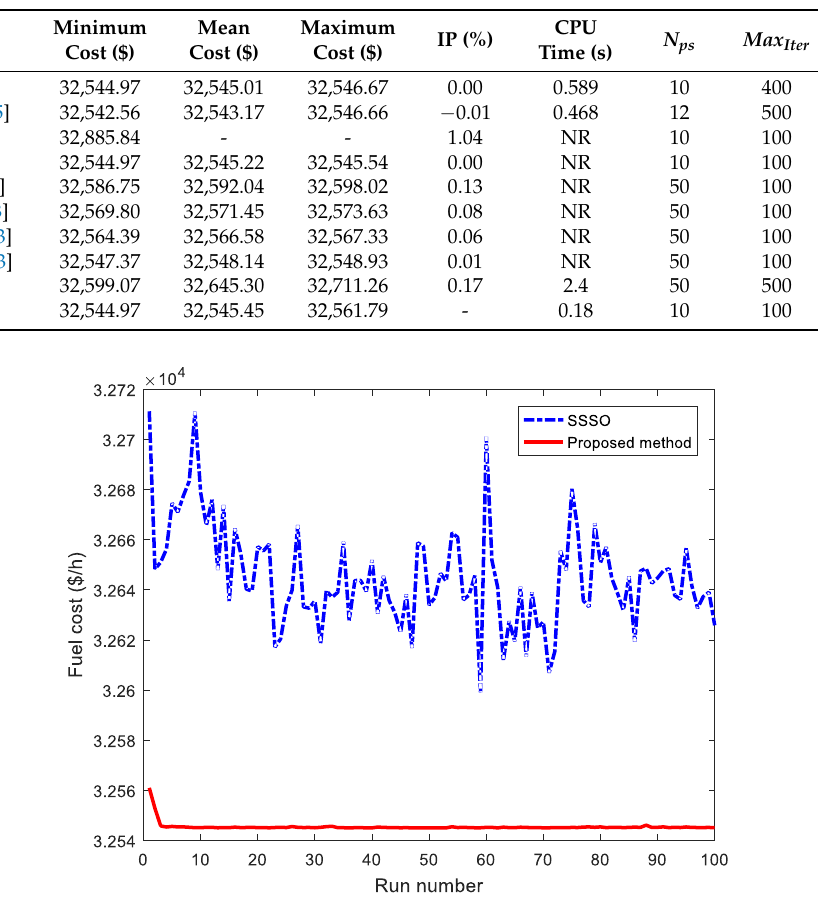
Figure 6. The best fitness functions of 100 runs obtained by SSSO and ISSO for system 3.